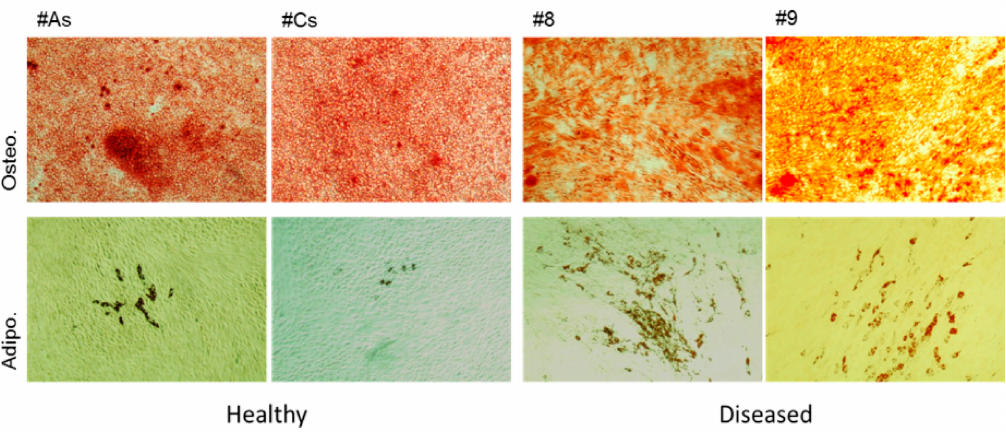
Figure 3. Flow cytometry data of cells derived from healthy ( left panel ) and diseased ( right panel ) gingiva both show identical expression of cell-surface markers characteristic of MSC. Cells were labeled with fluorescent conjugated antibodies and characterized using flow-cytometry.